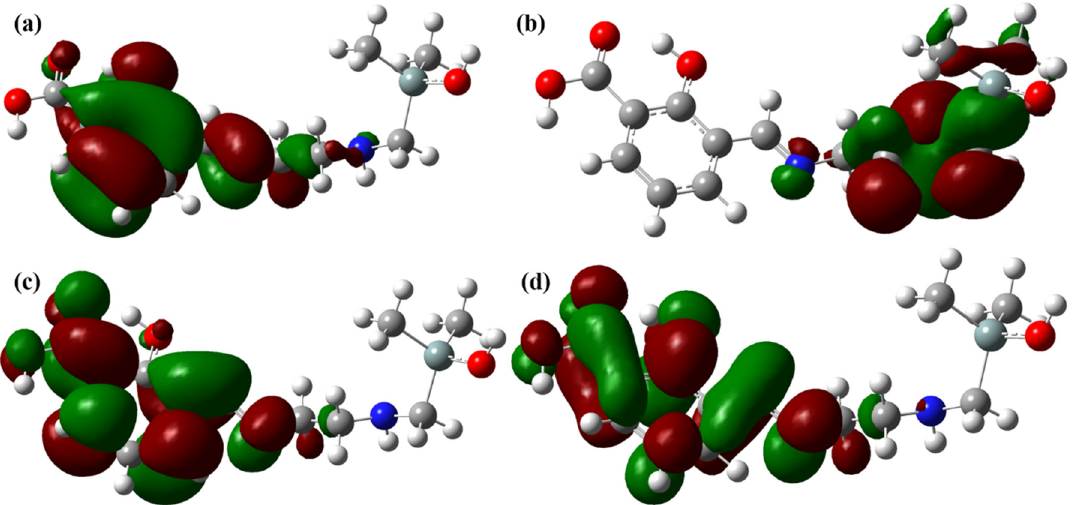
Figure 9. ( a ) HOMO − 1, ( b ) HOMO, ( c ) LUMO, ( d ) LUMO + 1 images, for the mono-Schiff base (SB-silanol) showing the silanol fragment.